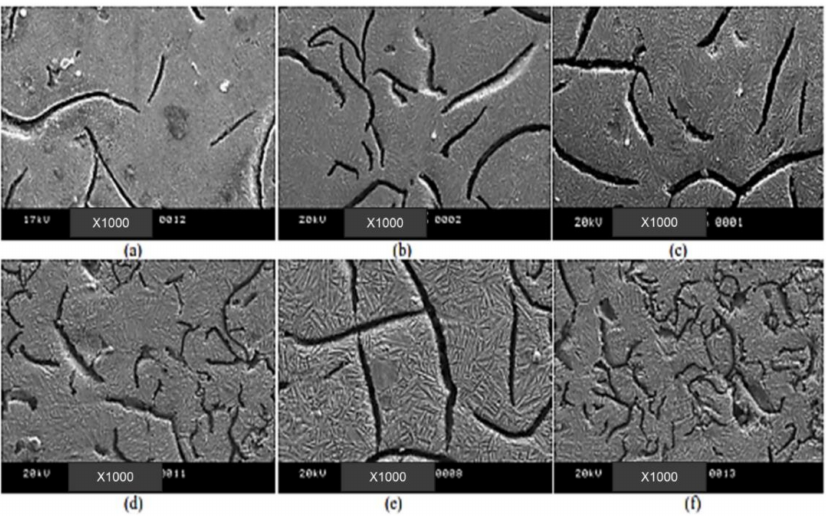
Figure 25. Morphological structures of specimens for 1 h at different austempering